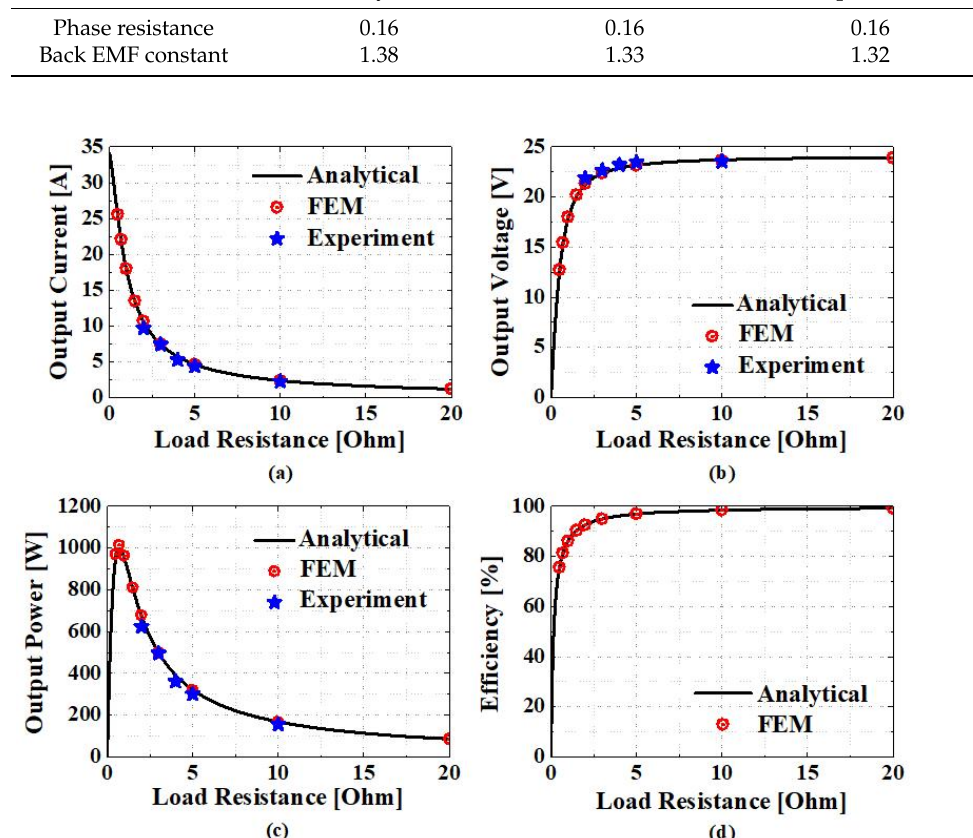
Figure 14. Results of characteristic analysis: ( a ) current curve, ( b ) voltage curve, ( c ) power curve, and ( d ) efficiency curve according to load resistance.